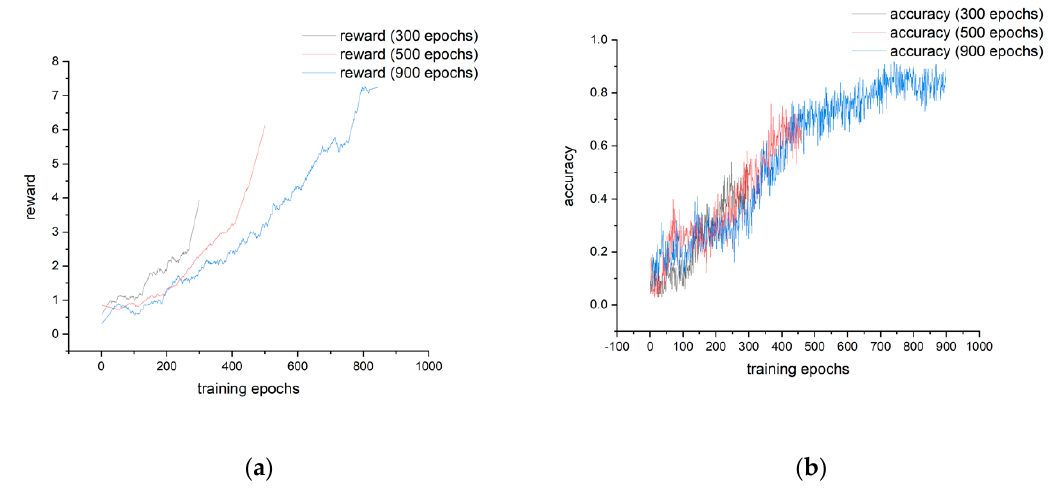
Figure 3. Training curves: ( a ) shows the cumulative reward curve of the proposed method in different epochs, ( b ) shows the accuracy curve of the proposed method in different epochs.